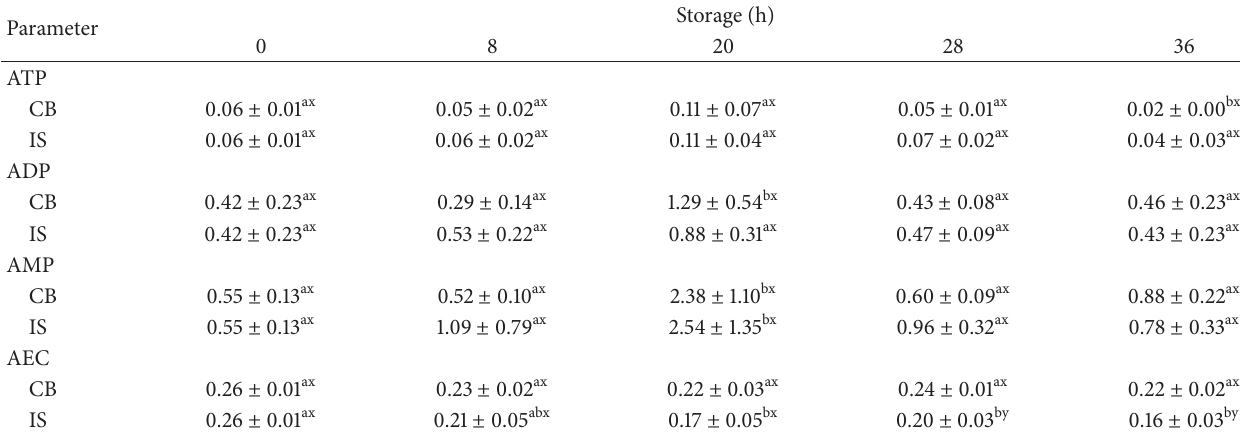
Table 1: Nucleotides, nucleosides ( 𝜇 mol/g dry weight), and AEC values of oyster Crassostrea gigas during in vivo transport in cardboard box (CB) and ixtle sacks (IS).